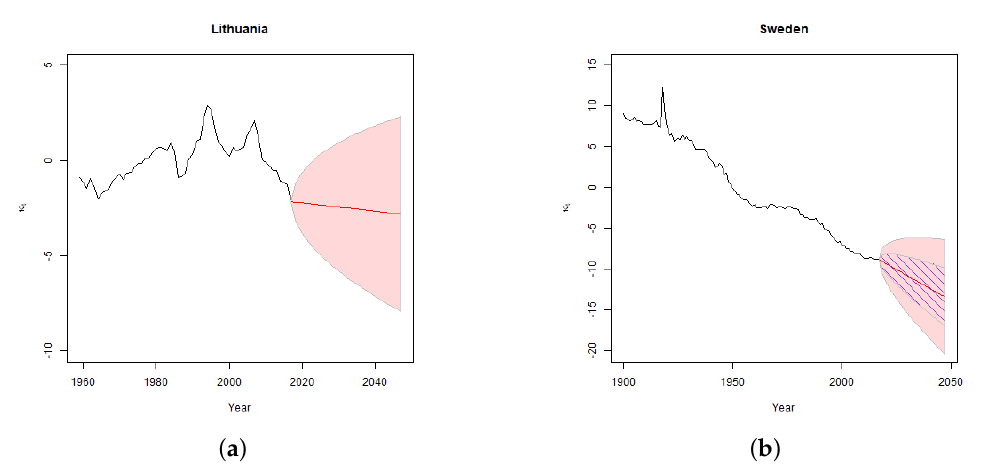
Figure 1. Results of estimation of classical Lee-Carter model parameter κ t for Lithuania ( a ) and Sweden ( b ), where the parameter was modelled as RWD. The pink shaded area provides 95% confidence intervals of the parameters derived by assuming Normal distribution of errors. In the Swedish case, the dashed area provides the same confidence intervals calculated by replacing the mortality rates of 1918 by the average of mortality rates of 1917 and 1919, and illustrates the effect of the outlier on the confidence intervals. No allowance for uncertainty in the drift is included in the above confidence